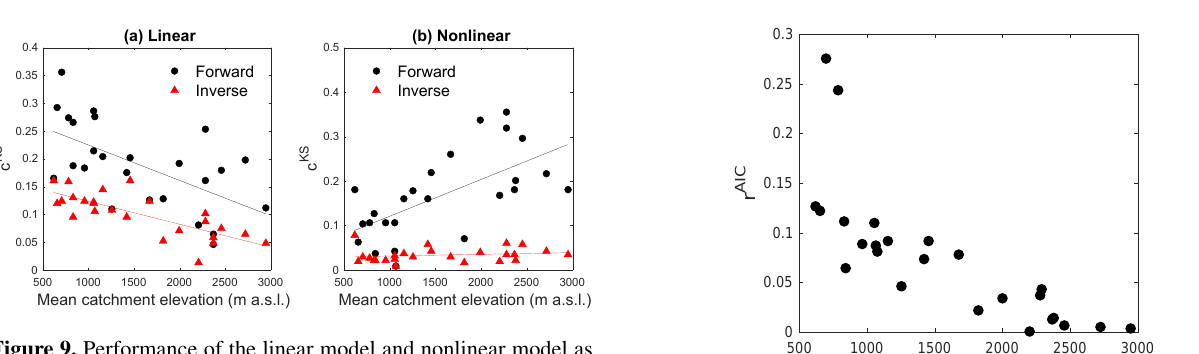
Figure 9. Performance of the linear model and nonlinear model as a function of mean catchment elevation. The performance measure shown, c KS , is zero for a perfect model.